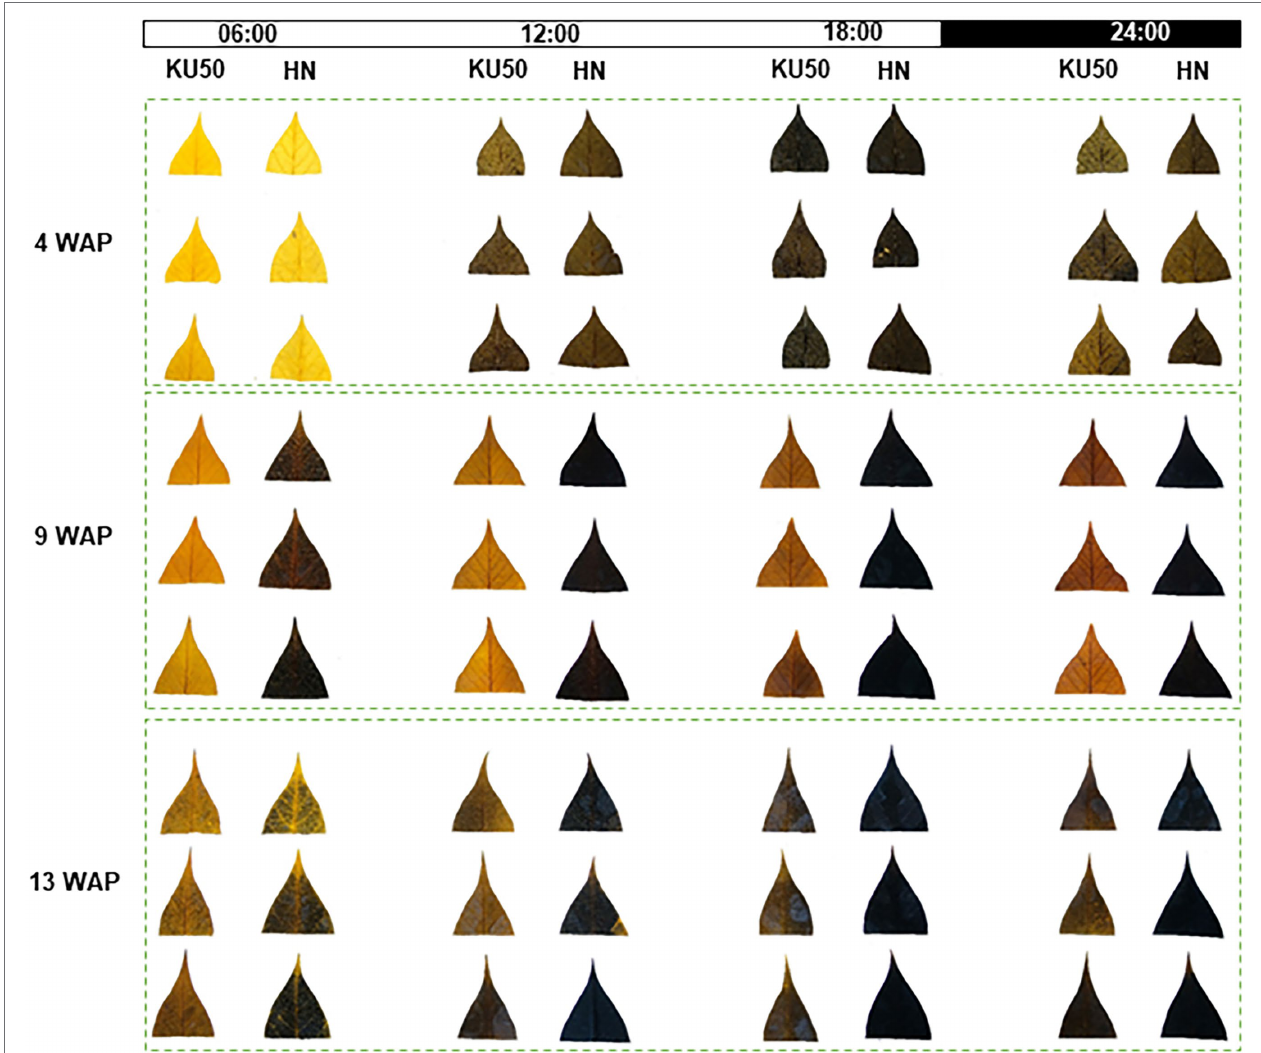
FIGURE 3 | Iodine staining of the youngest fully expanded mature leaves of Kasetsart 50 (KU50) and Hanatee (HN) cassava varieties during 4–13 weeks after planting (WAP) in diurnal